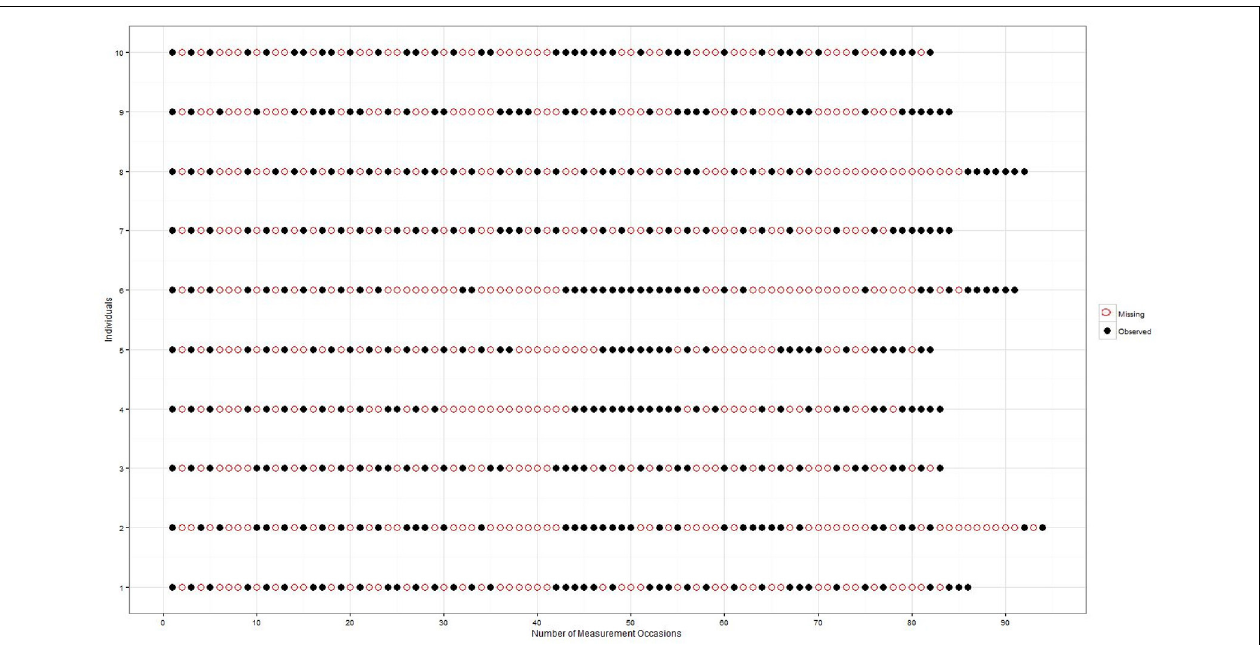
FIGURE 1 | Missing data pattern of 10 different individuals over 2 years in weeks.